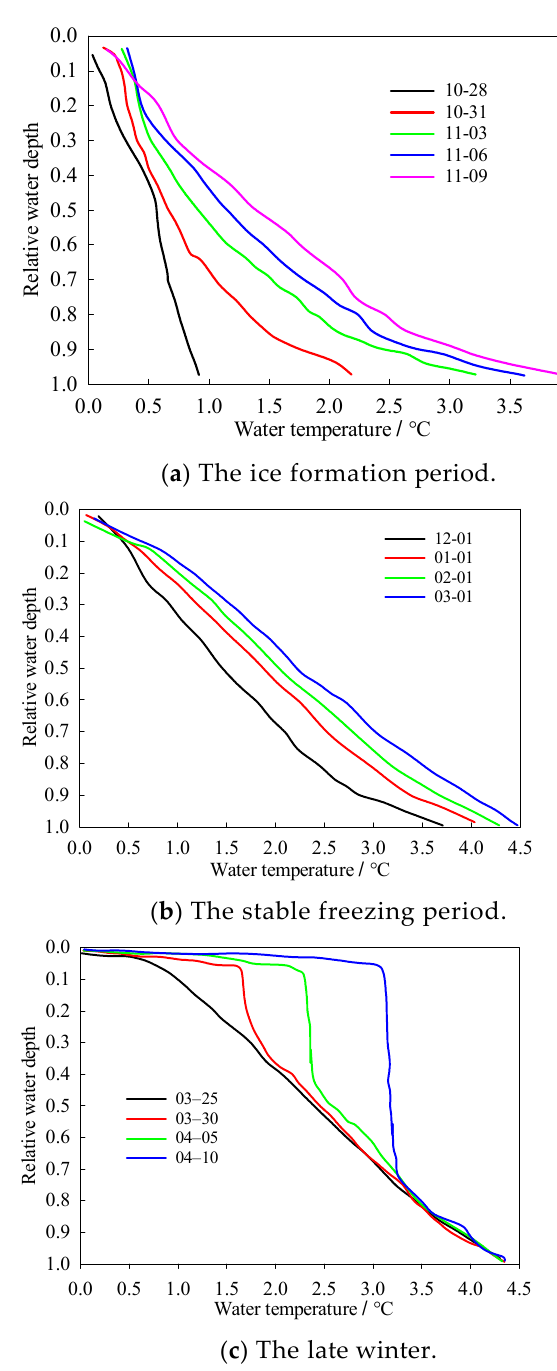
Figure 6. Vertical profiles of water temperature in the ice-cover duration. During the first period, temperature inversion occurred vertically in the water on 28 October when the ice cover took shape. Nevertheless, the temperature gradient appeared small, standing at around 0.8 K/m, and the water temperature was uniformly distributed. As the ice cover gradually thickened, the bulk temperature of the water went up and the temperature gradient widened. Meanwhile, the gradient in the hypolimnion, up to 7.6 K/m at a maximum, was significantly larger than that in the epilimnion. In a stable freezing period, the water temperature was linearly distributed in the vertical direction, while the temperature gradient averaged around 5.3 K/m. Ice cover was relatively thicker, making it more difficult for the sensible atmospheric heat and so-